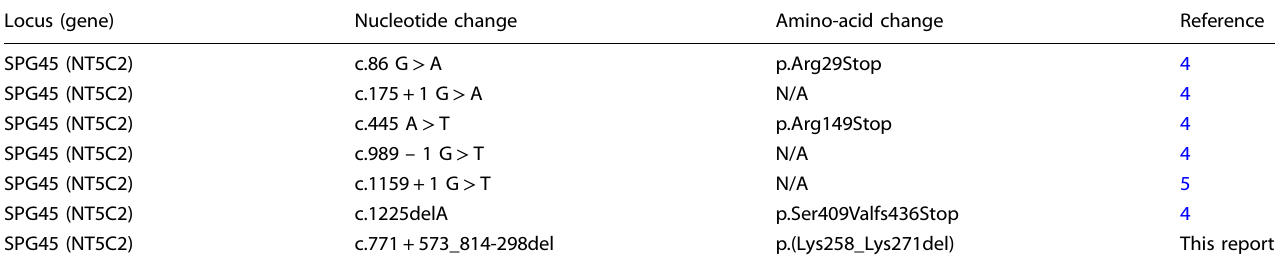
Table 2. All NT5C2 mutations reported in HSP families Locus